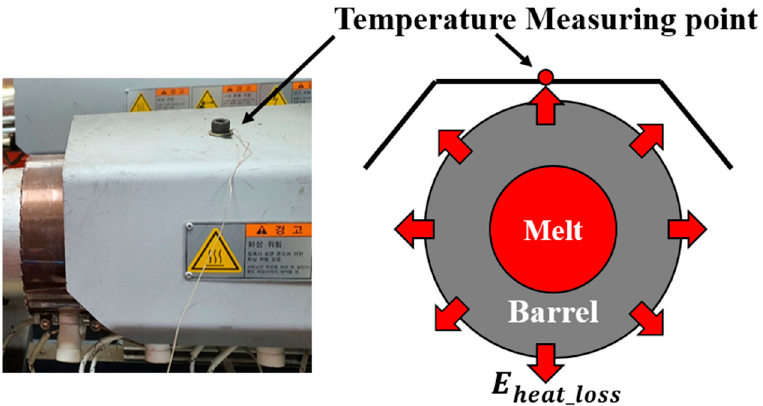
Figure 5. Temperature measurement at the top of the safety guard of the barrel to approximate the heat transfer rate to the surroundings.